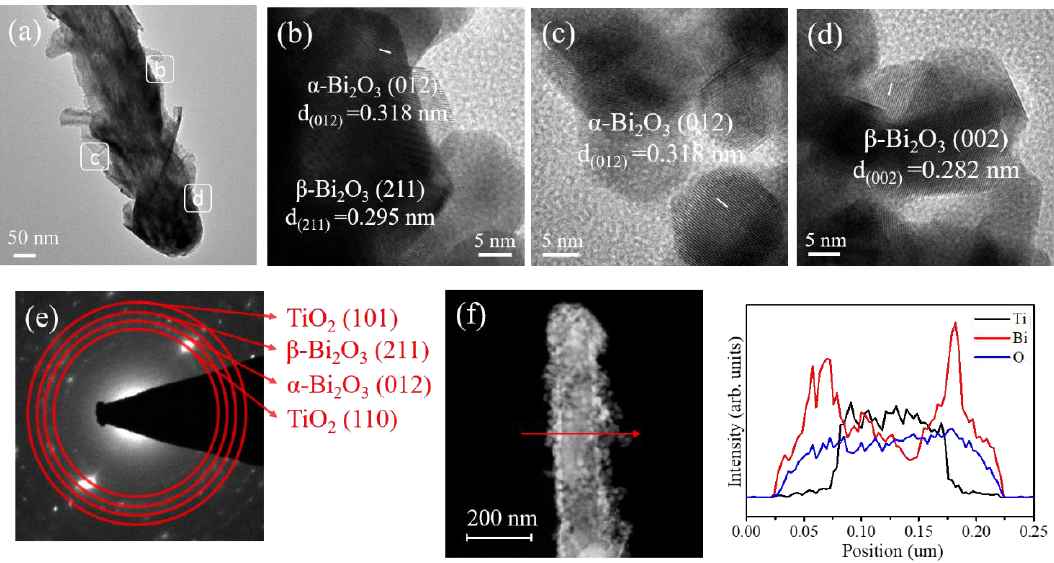
Figure 4. TEM analysis of the TiO 2 /a – Bi 2 O 3 rods: ( a ) Low-magnification TEM image. ( b – d ) HRTEM images taken from various regions of the composite rod. ( e ) SAED pattern of several TiO 2 /a – Bi 2 O 3 rods. ( f ) EDS line scanning profiles across the composite rod.